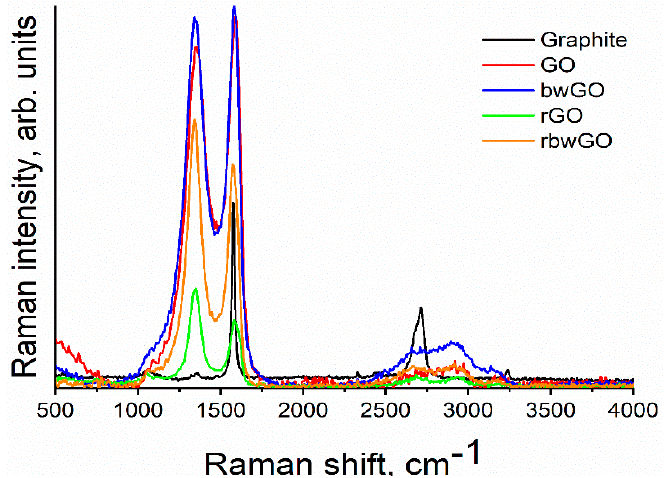
Figure 5. Raman spectra of graphene oxide samples.